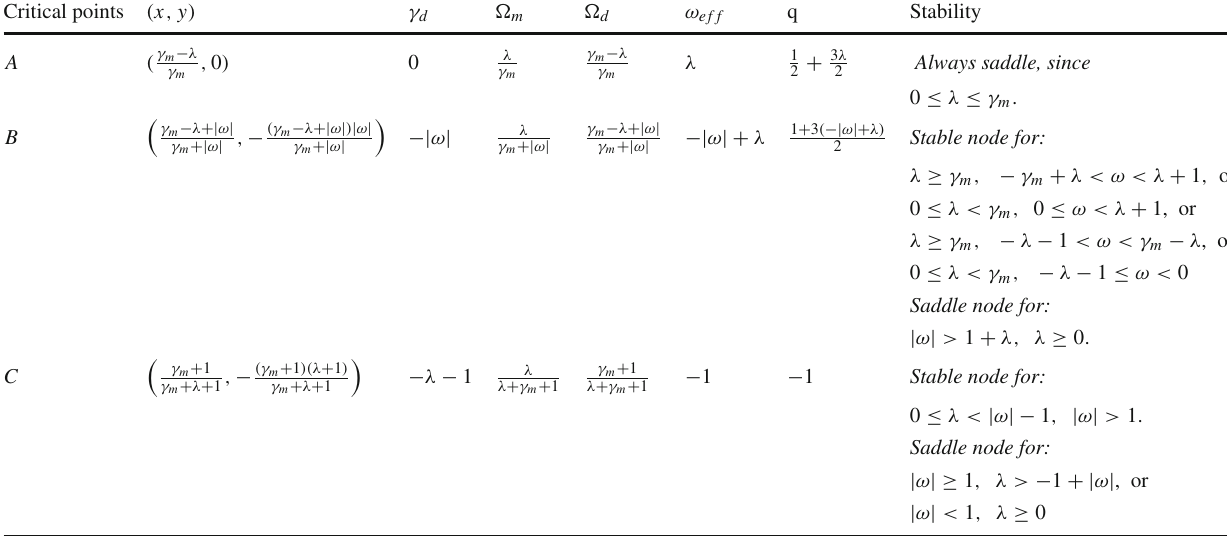
Table 1 Critical points, corresponding cosmological parameters and stability of critical points for the interaction model (8) are presented, where 0 ≤ γ m ≤ 1 Critical points ( x , y ) γ d (cid:7) m (cid:7) d ω ef f q Stability A 1